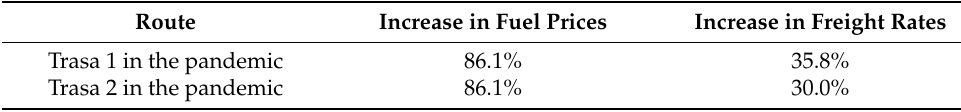
Table 7. Changes in fuel prices and transport